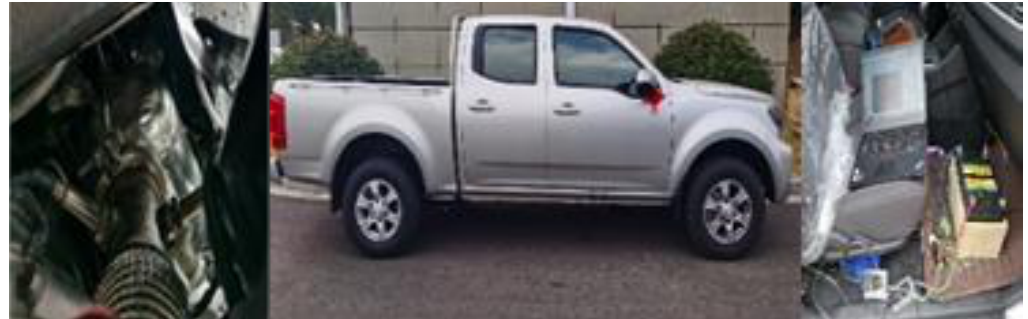
Figure 8. Diesel pickup truck.